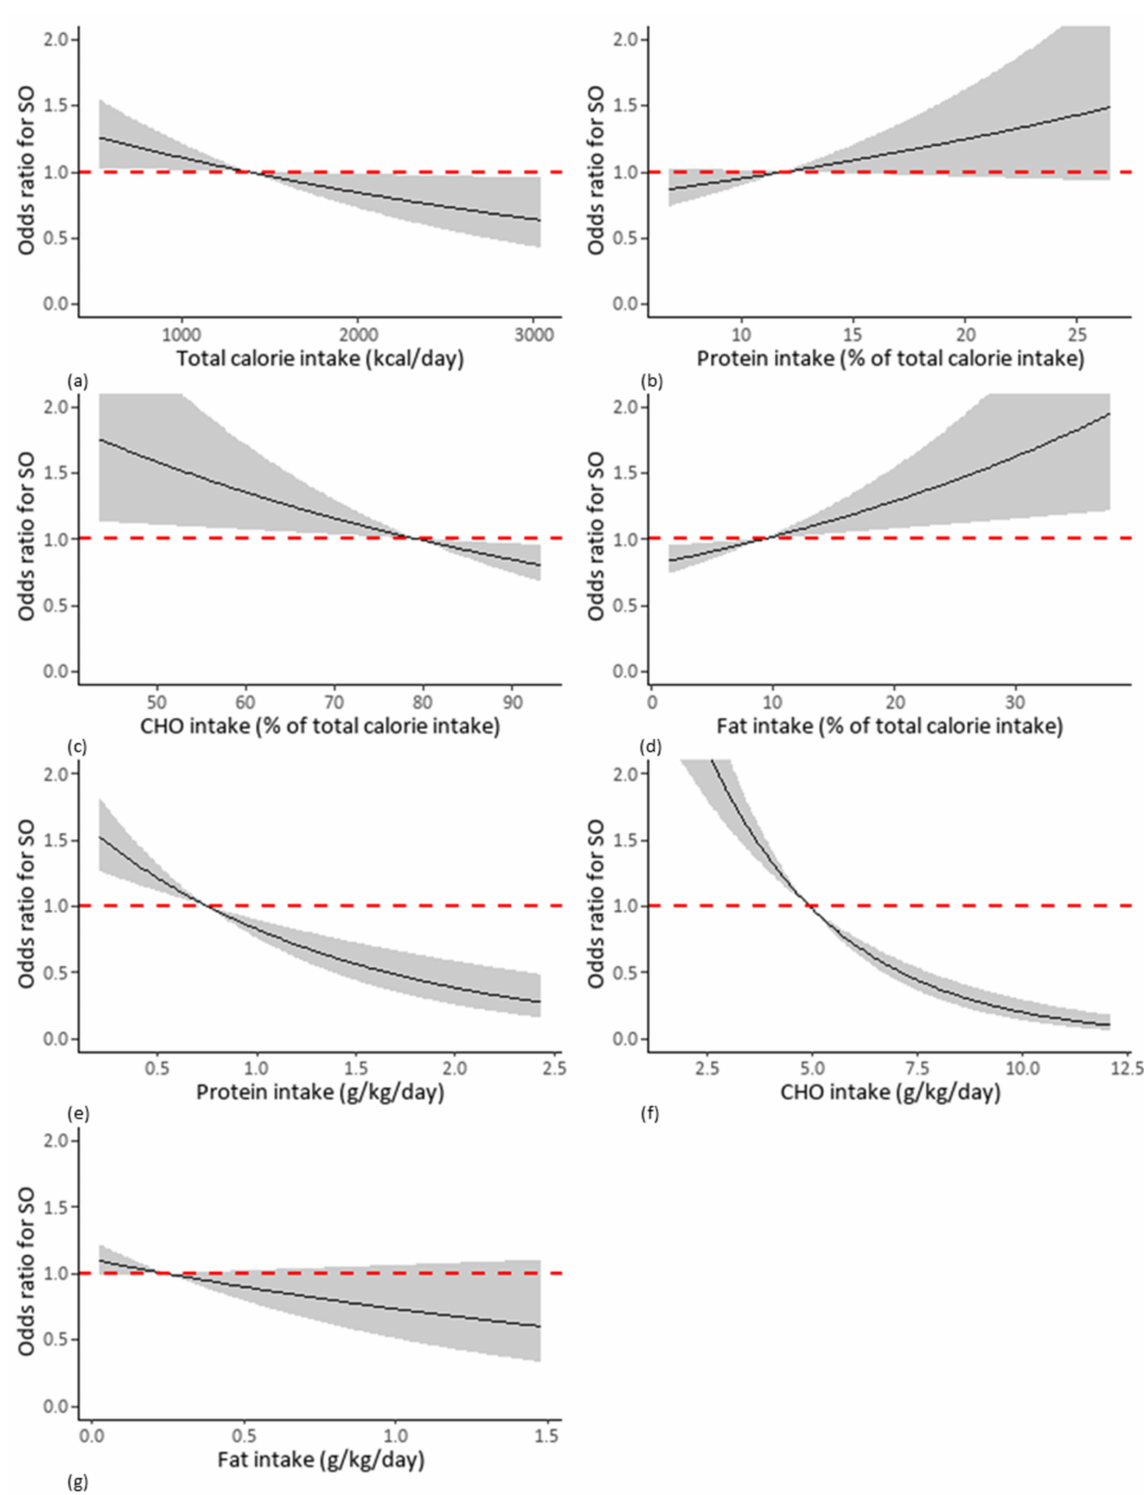
Figure 4. Cubic spline curves showing relationship between OR for SO and each pattern of macronutrient intake in women. Each pattern of macronutrients intake consists of ( a ) total calorie intake (kcal/day), ( b ) percentage of calorie intake from protein intake, ( c ) percentage of calorie intake from CHO, ( d ) percentage of calorie intake from fat, ( e ) protein intake per body weight, ( f ) CHO intake per body weight, ( g ) fat intake per body weight. Abbreviations: OR, odds ratio; SO, sarcopenic obesity; CHO,